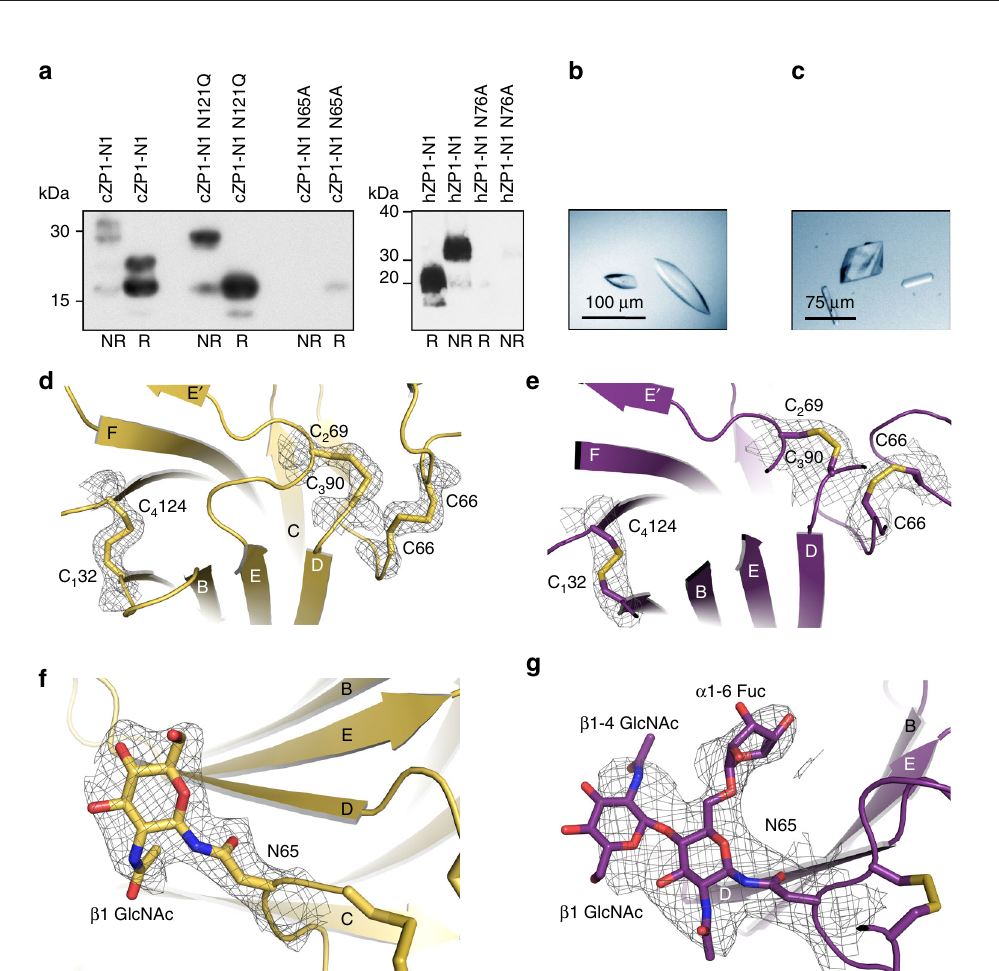
Fig. 2 The cross-linking function of ZP1 maps to its N-terminal ZP-N1 domain. a Domain architecture of cZP1, with feature names abbreviated as in Fig. 1a. b Coomassie-stained SDS-PAGE analysis of insoluble (pellet; P) and soluble (S) fractions of native chicken egg coat material that was either untreated or incubated with a sperm protease extract prepared from acrosome-reacted sperm 44 . c Immunoblot analysis using anti-cZP1 N-terminal fragment polyclonal 57 con fi rms the presence of cZP1-N1 in the soluble fraction of egg coat material treated with sperm extract. d Silver-stained SDS-PAGE analysis of a size-exclusion chromatography (SEC) separation of the sperm protease-solubilised egg coat material. e SEC fractions 44-54 contain cZP1-N1 as evidenced by ELISA analysis using anti-cZP1 N-terminal fragment polyclonal 57 . Bands corresponding to the dimer and monomer of cZP1-N1 released from the egg coat were in-gel digested with chymotrypsin and trypsin, followed by MALDI-MS/MS to con fi rm their protein sequences. f Immunoblot analysis of SEC fractions 45 – 53 indicates that the ~35 kDa protein in these fractions is a disulphide-linked dimer of the ~21 kDa protein containing cZP1-N1. g , h Anti- 5His immunoblot of recombinant cZP1-N1 and cZP1 L600-R958 (panel g ), as well as full-length cZP1 (panel h ). Only cZP1-N1 forms a covalent homodimer like full-length cZP1. i Anti-5His immunoblot analysis shows that secreted hZP1-N1 also forms a covalent homodimer. j SEC-MALS analysis shows that puri fi ed hZP1 A195-P590 produced in HEK293S cells has a molecular mass of ~50 kDa (red pro fi le), consistent with the calculated mass of a monomeric species carrying 2 GlcNac residues (43 kDa). Calibration was carried out using BSA, whose molecular mass detection is shown in blue